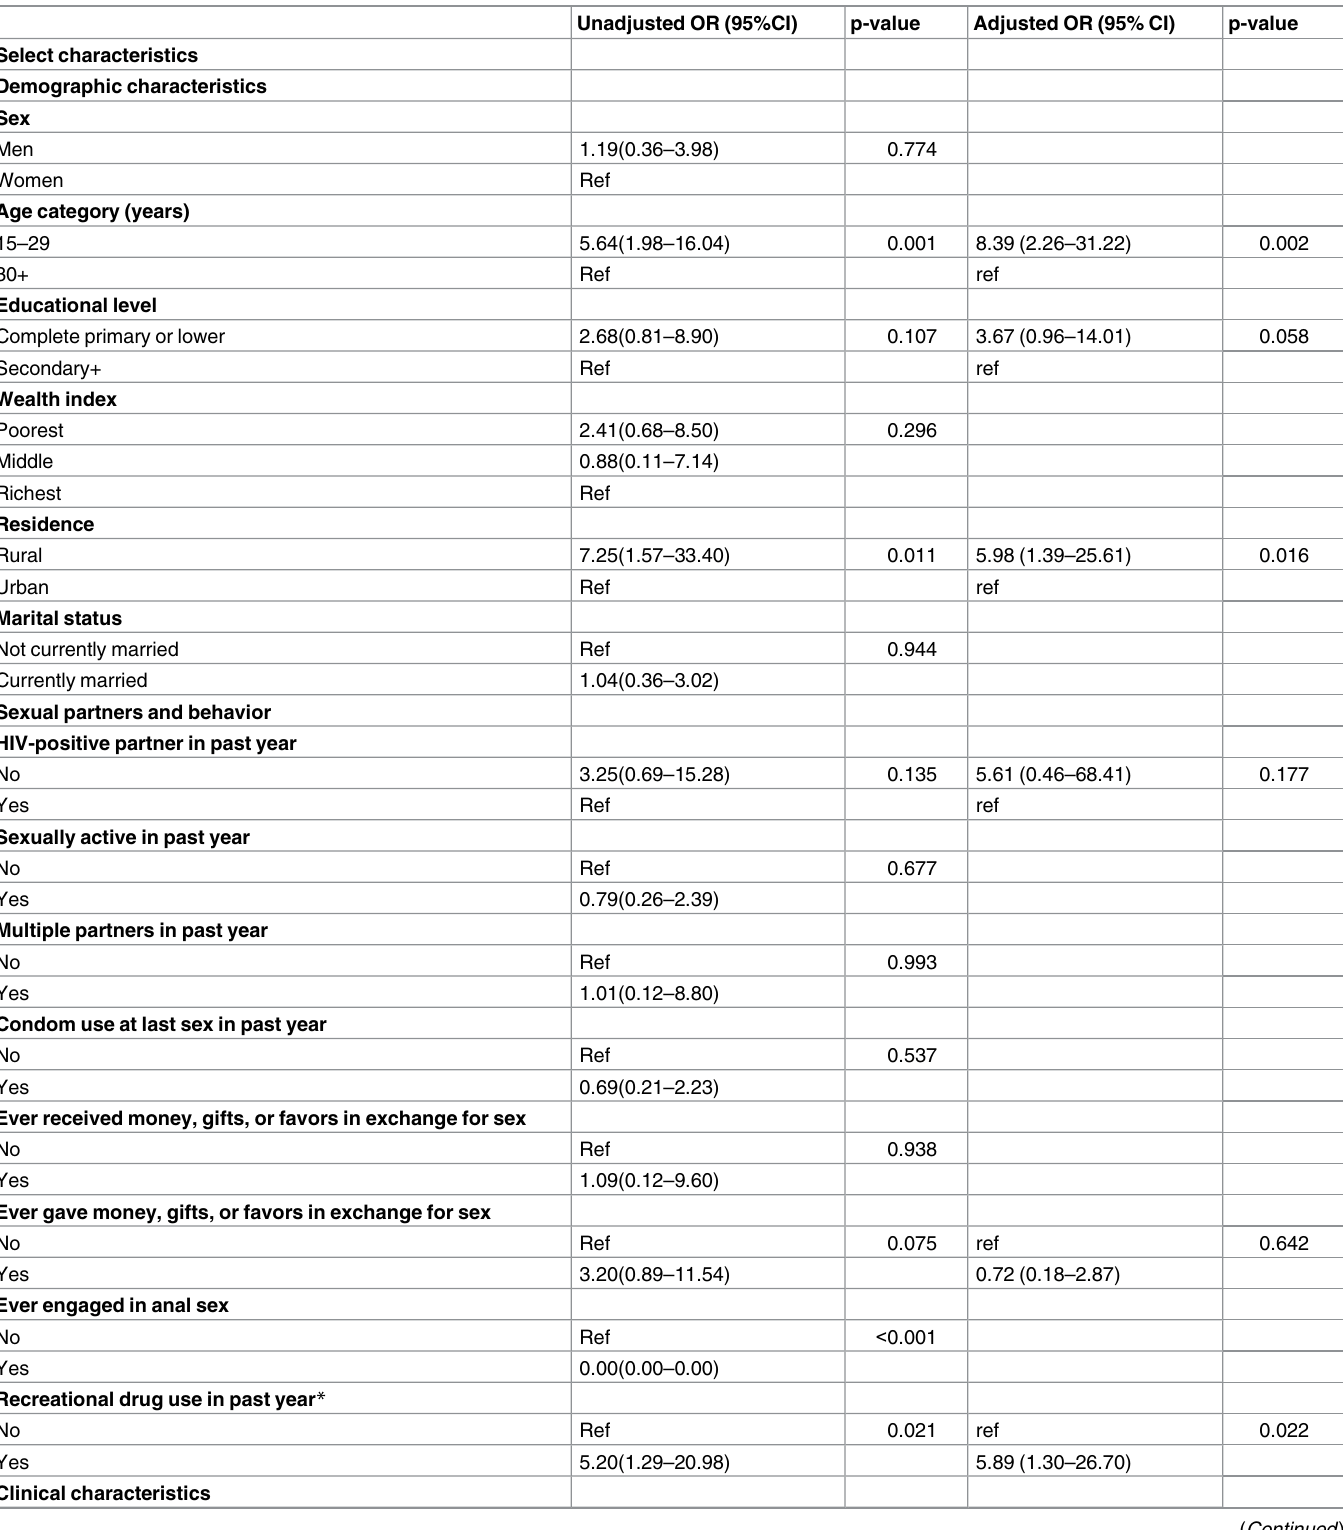
Table 2. Factors associated with non-adherence to ARV drugs among HIV-infected persons receiving antiretroviral therapy, Kenya,